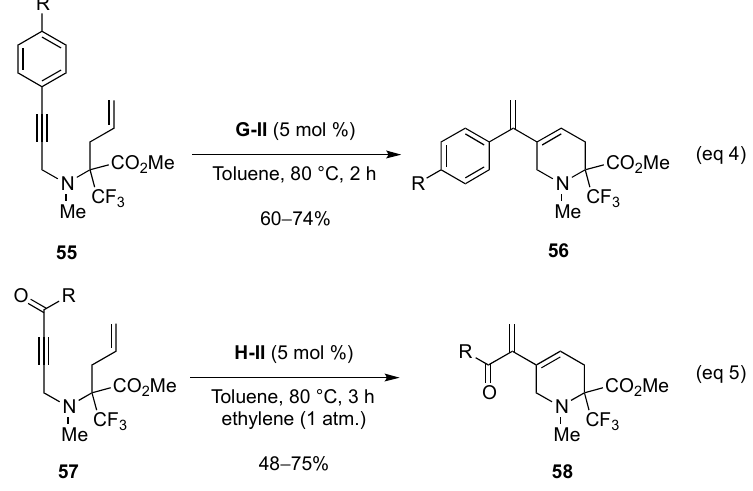
Table 1. Aza Diels-Alder